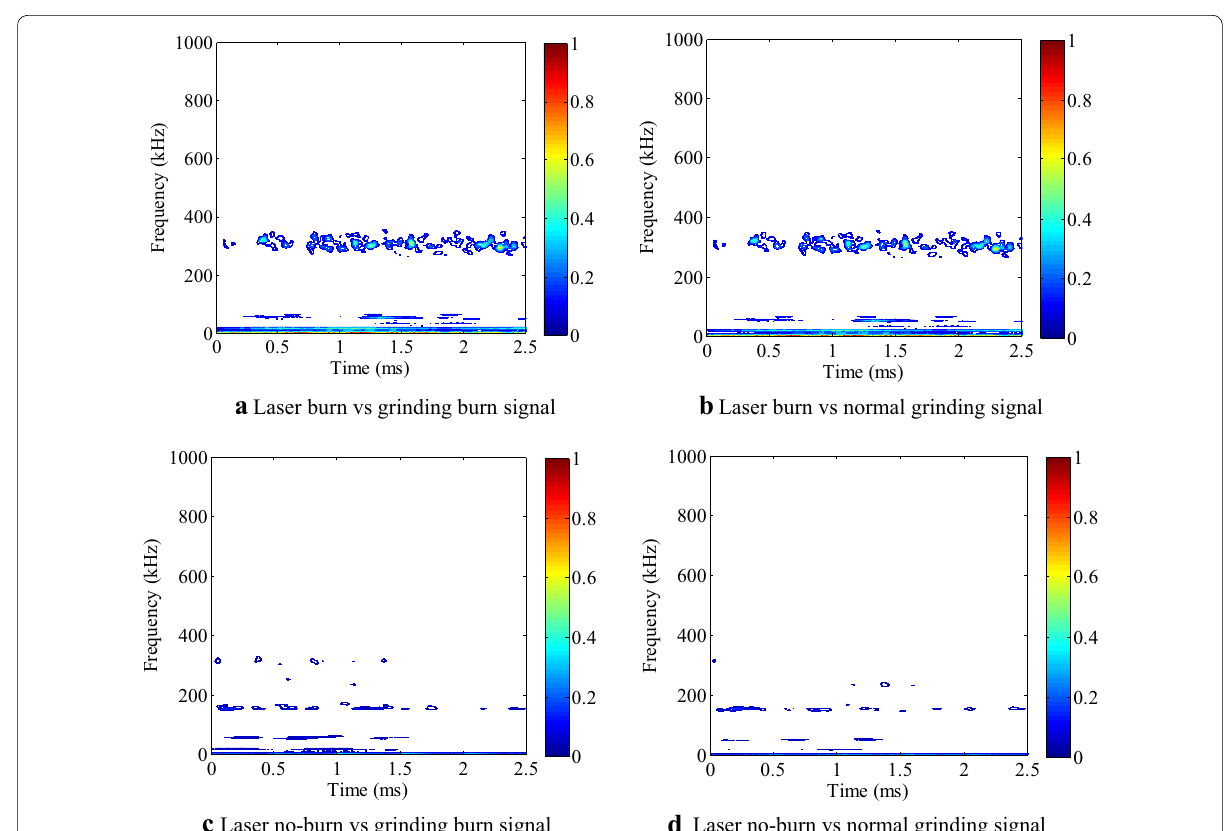
Figure 8 XWT of laser and grinding